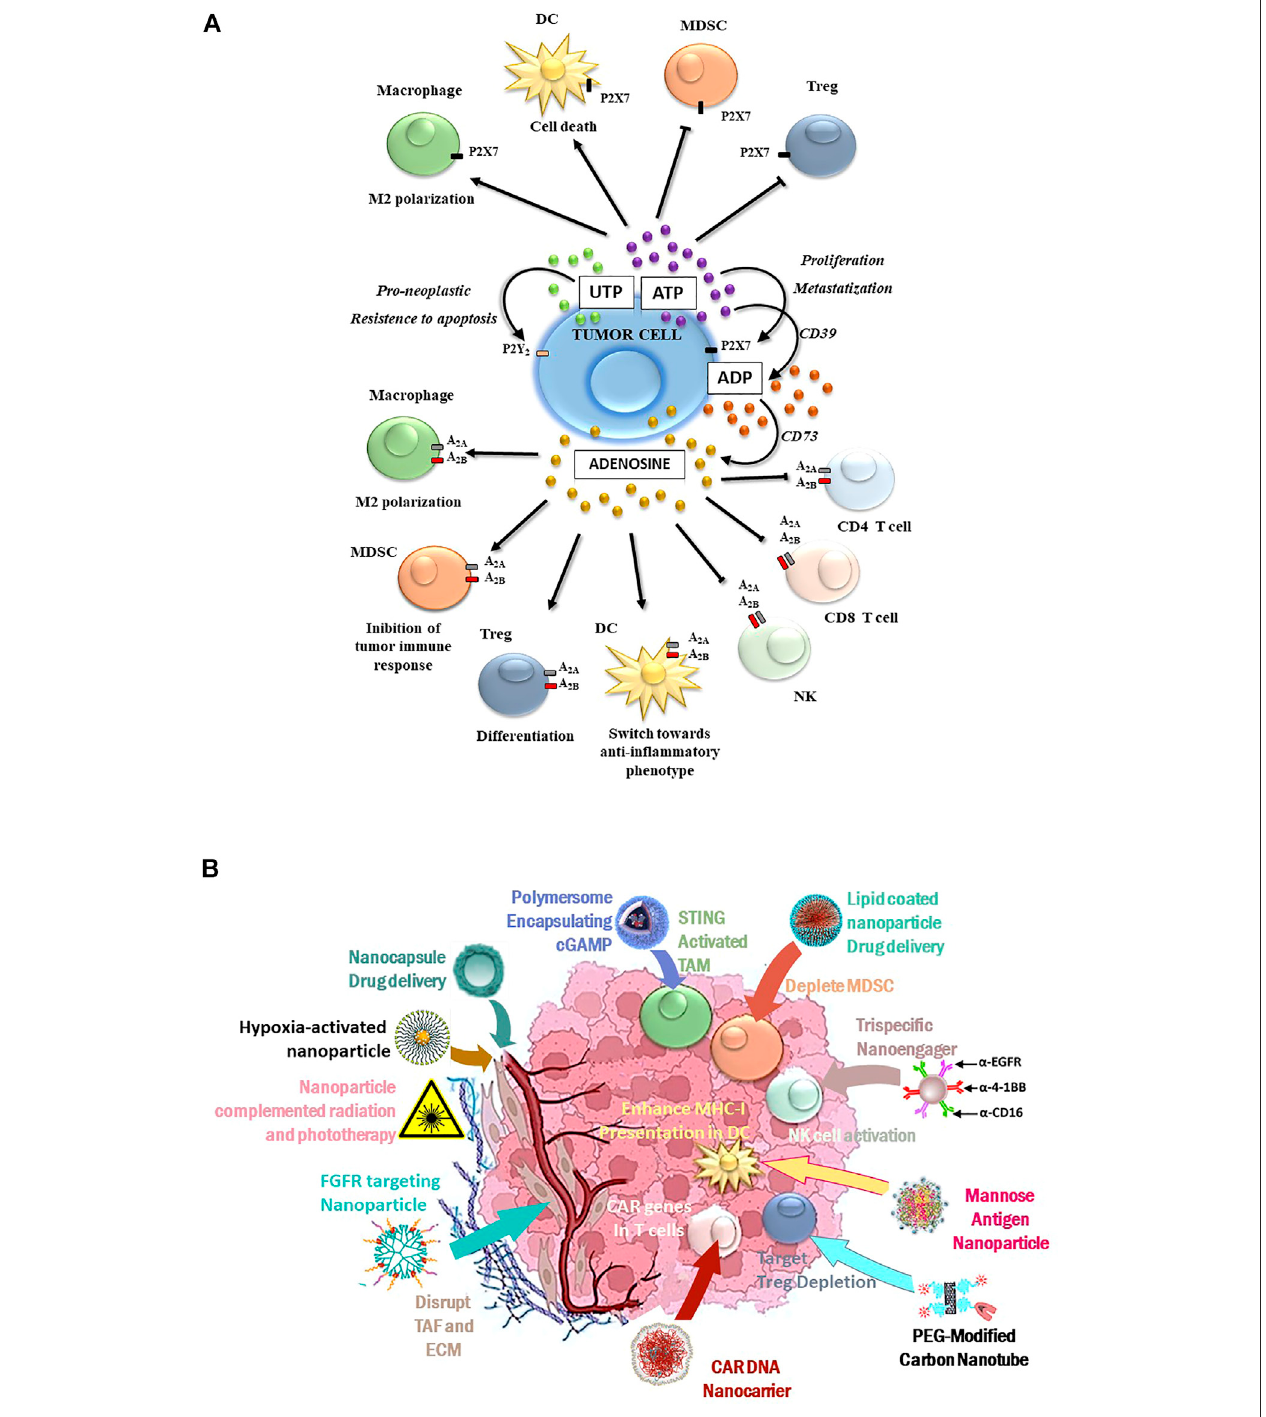
FIGURE 1 | (A) Purinergic-mediated responses occurring in the TME: P2 receptor-induced activities are summarized in the upper part of the fi gure, while P1 receptor-mediated responses are depicted in the lower fi gure part. (B) Schematic diagram for tailored nanoparticles targeting the TME and its immunological components to potentiate cancer immune